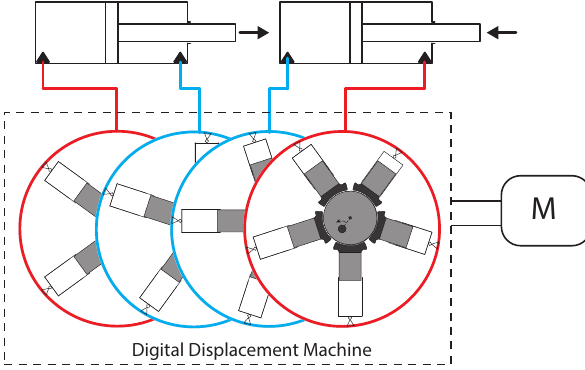
Figure 17: Conceptional drawing of a multiple cylinder digital displacement direct cylinder